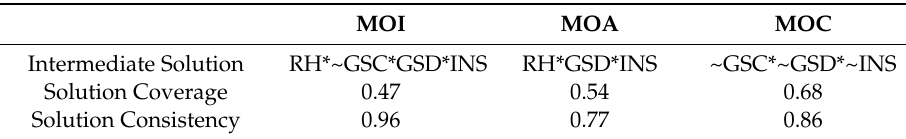
Table 10. Di ff erent selection paths of IHC organization modes